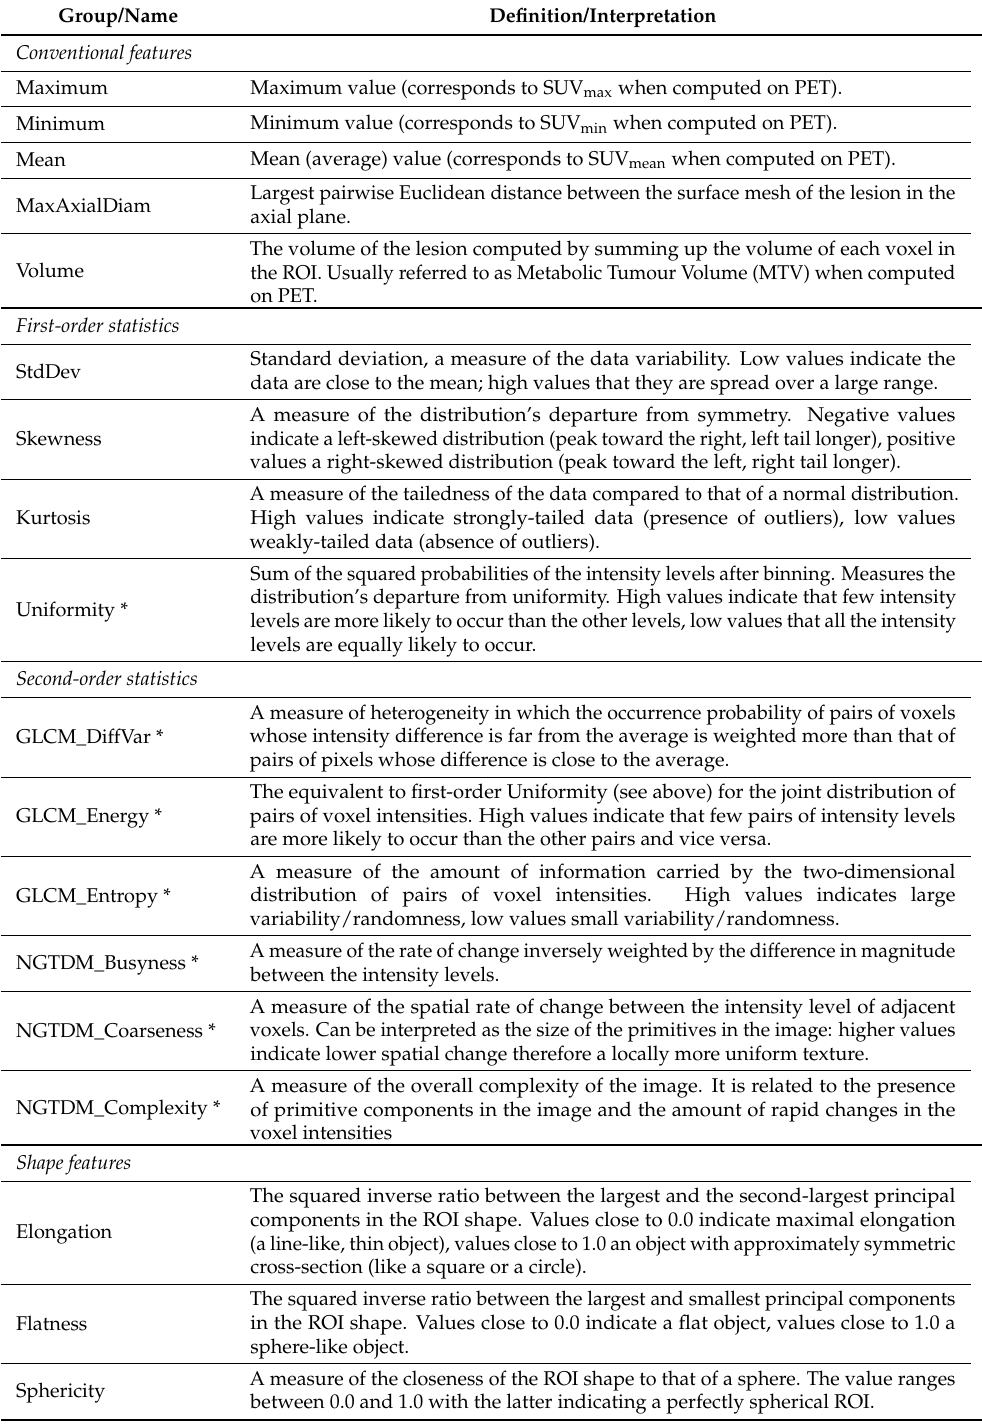
Table 2. Summary table of the radiomics features considered in the study. Key to abbreviations: ‘GLCM’ = Grey-Level Co-occurrence Matrix, ‘NGTDM’ = Neighbouring Gray-Tone Difference Matrix. Features that require binning are marked with an